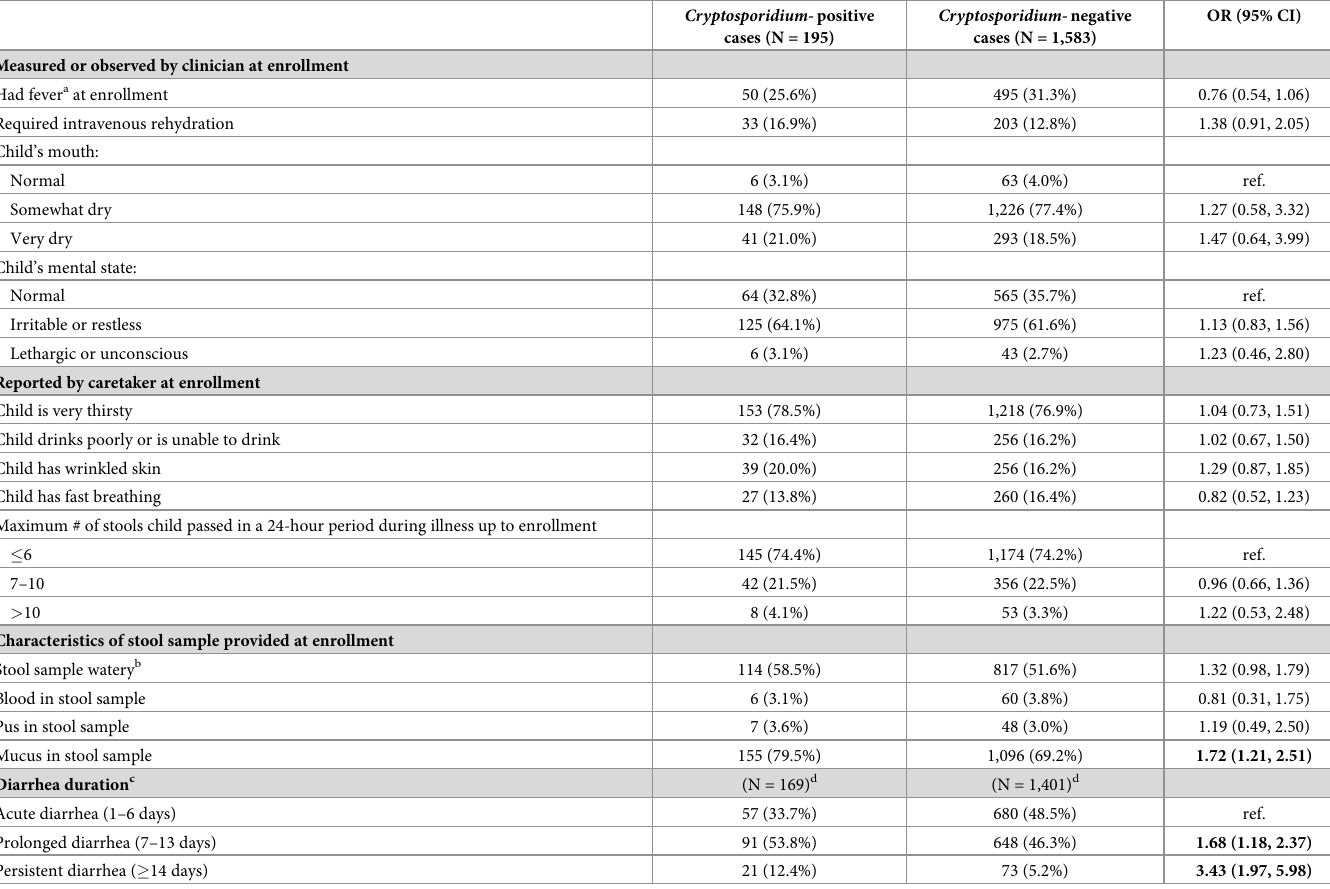
Table 2. Clinical presentation of GEMS-Kenya cases (N = 1,778) by Cryptosporidium status, western Kenya,